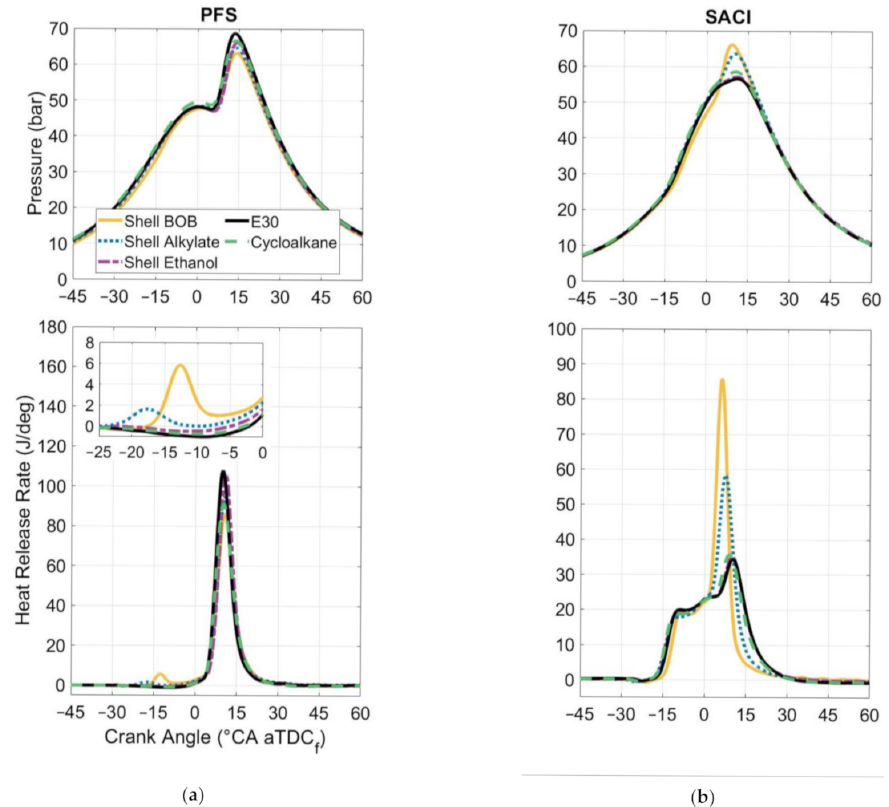
Figure 10. Pressure and heat release for ( a ) PFS operation at 10 ◦ CA aTDC f , and ( b ) SACI operation at 5 ◦ CA aTDC f